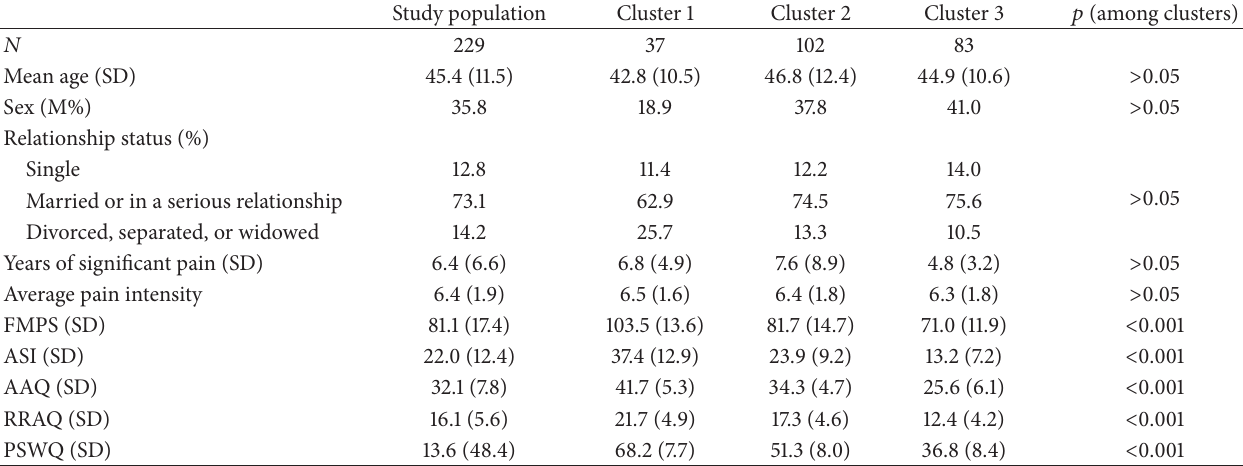
Table 1: Demographic and clinical characteristics of study population and participants subdivided into the three cluster subgroups.